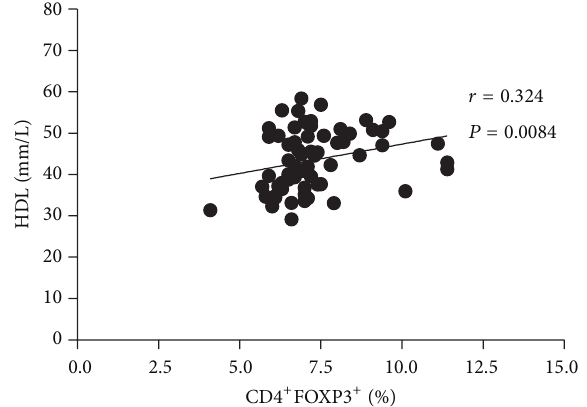
Figure 4: Increase in the HDL levels correlated with Treg frequency. Correlation of HDL levels with the percentage of Treg in the individuals of the study. Spearman coefficient ( 𝑟 ) and 𝑃 values are shown in the